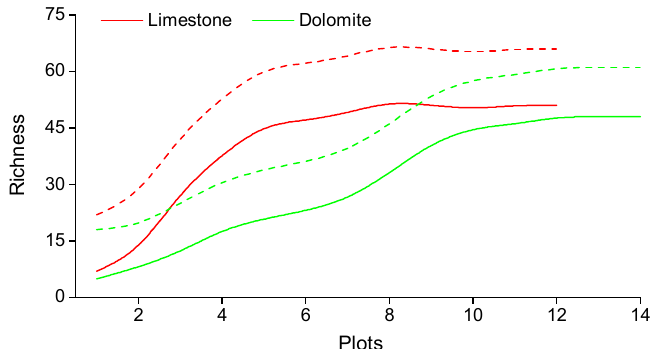
Figure 2. Species accumulation curves (SACs) relating total species richness to dolomite and limestone karst-forest sampling-plot treatment. The solid line represents the SAC and the dashed line represents one positive standard deviation.